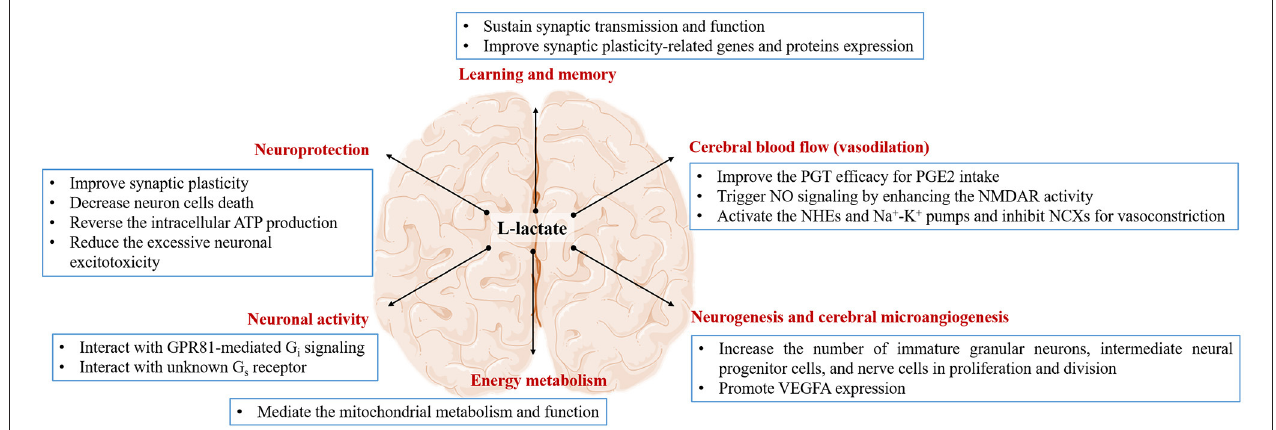
FIGURE 2 | The effect of L-lactate and its possible mechanism on the brain. L-lactate is capable of regulating brain function in the terms of learning and memory, cerebral blood flow, neurogenesis and cerebral microangiogenesis, energy metabolism, neuronal activity, and neuroprotection via different